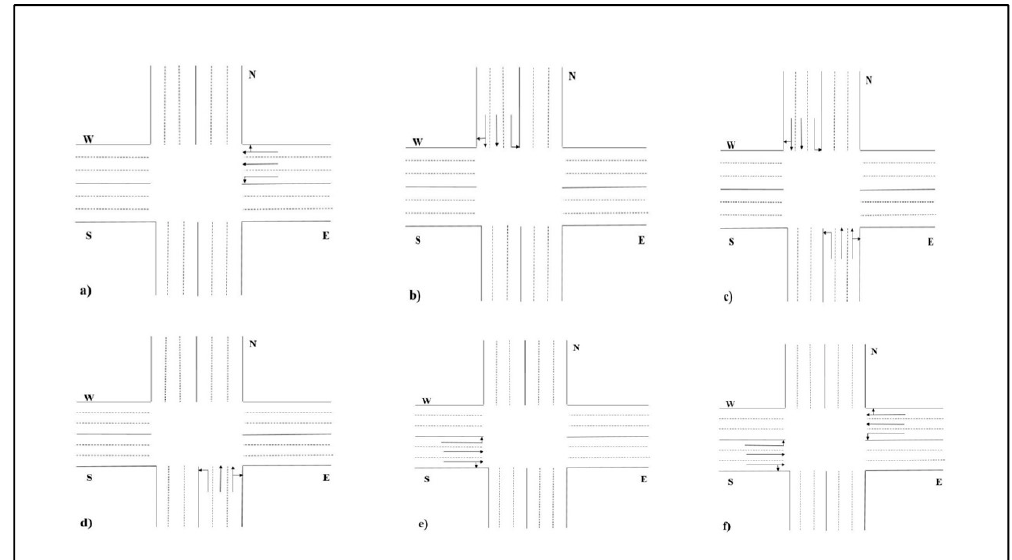
Figure 3. Phases implemented in Shiraz City: ( a ) east to west, ( b ) north to south, ( c ) north to south, ( d ) south to north, ( e ) west to east. ( f ) west to east.